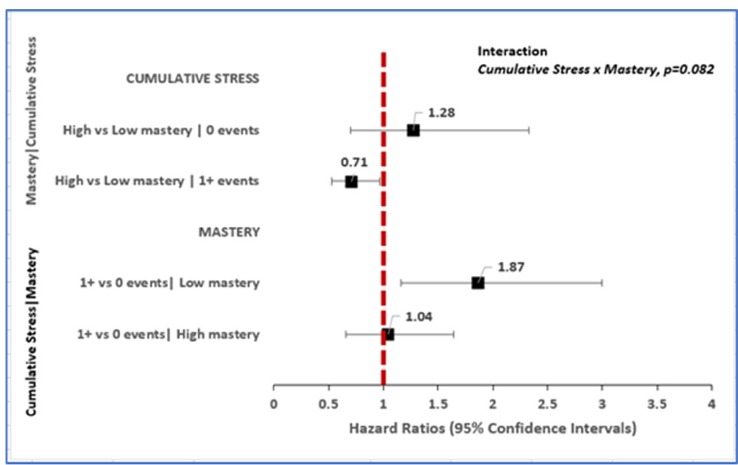
Figure 4. Cumulative stress-related differences in risk of incident dementia vary within strata of